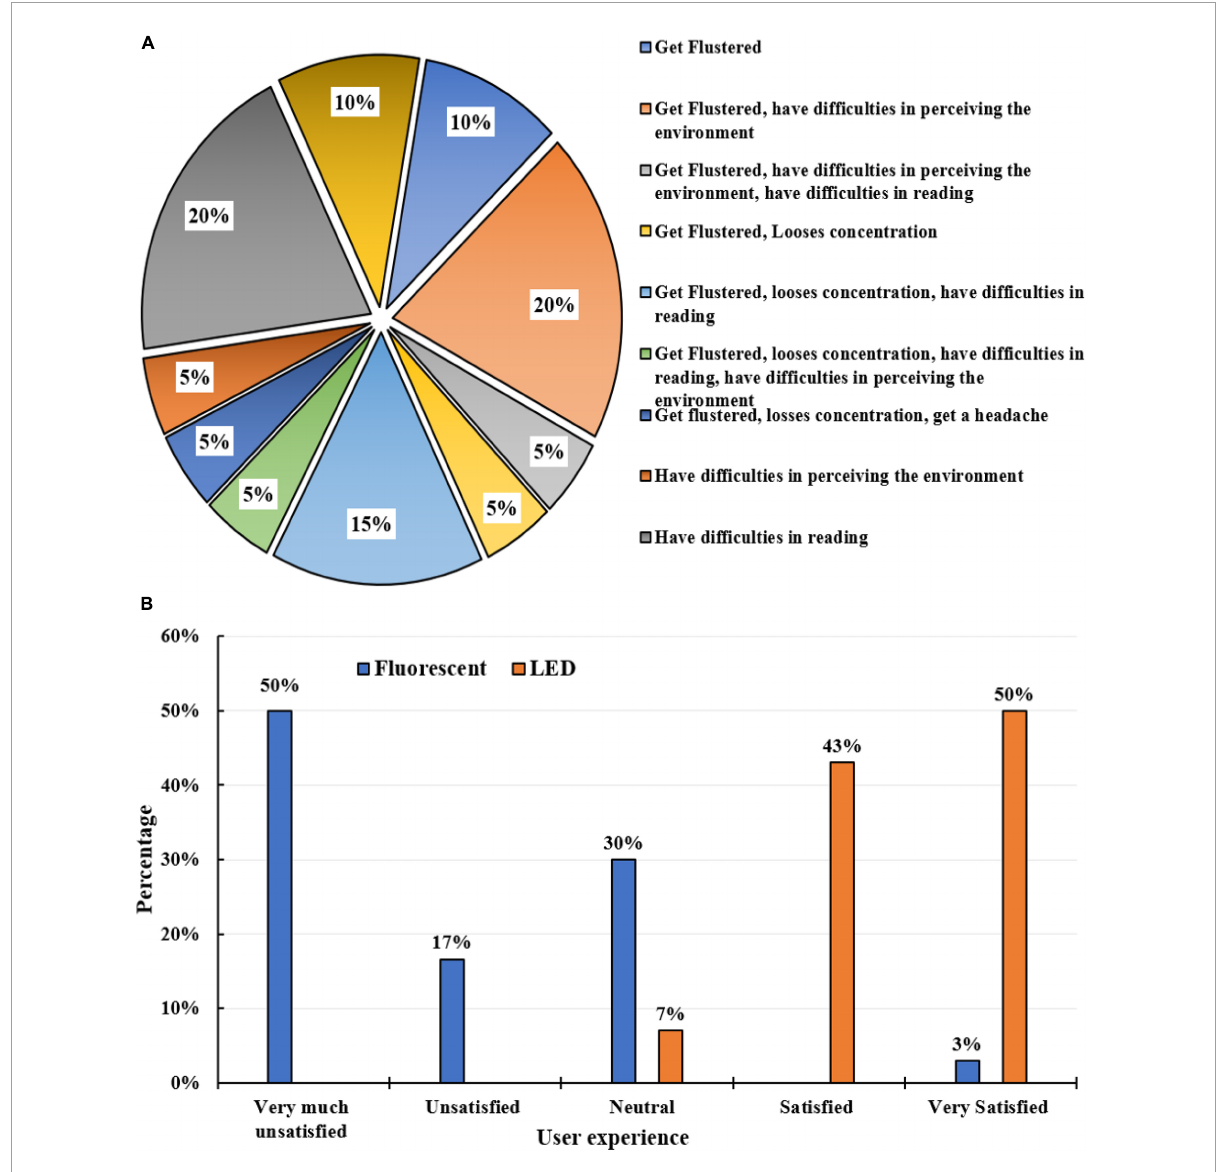
FIGURE3 (A) The behavior of autistic children under low light conditions, (B) preferable light bulb for autistic